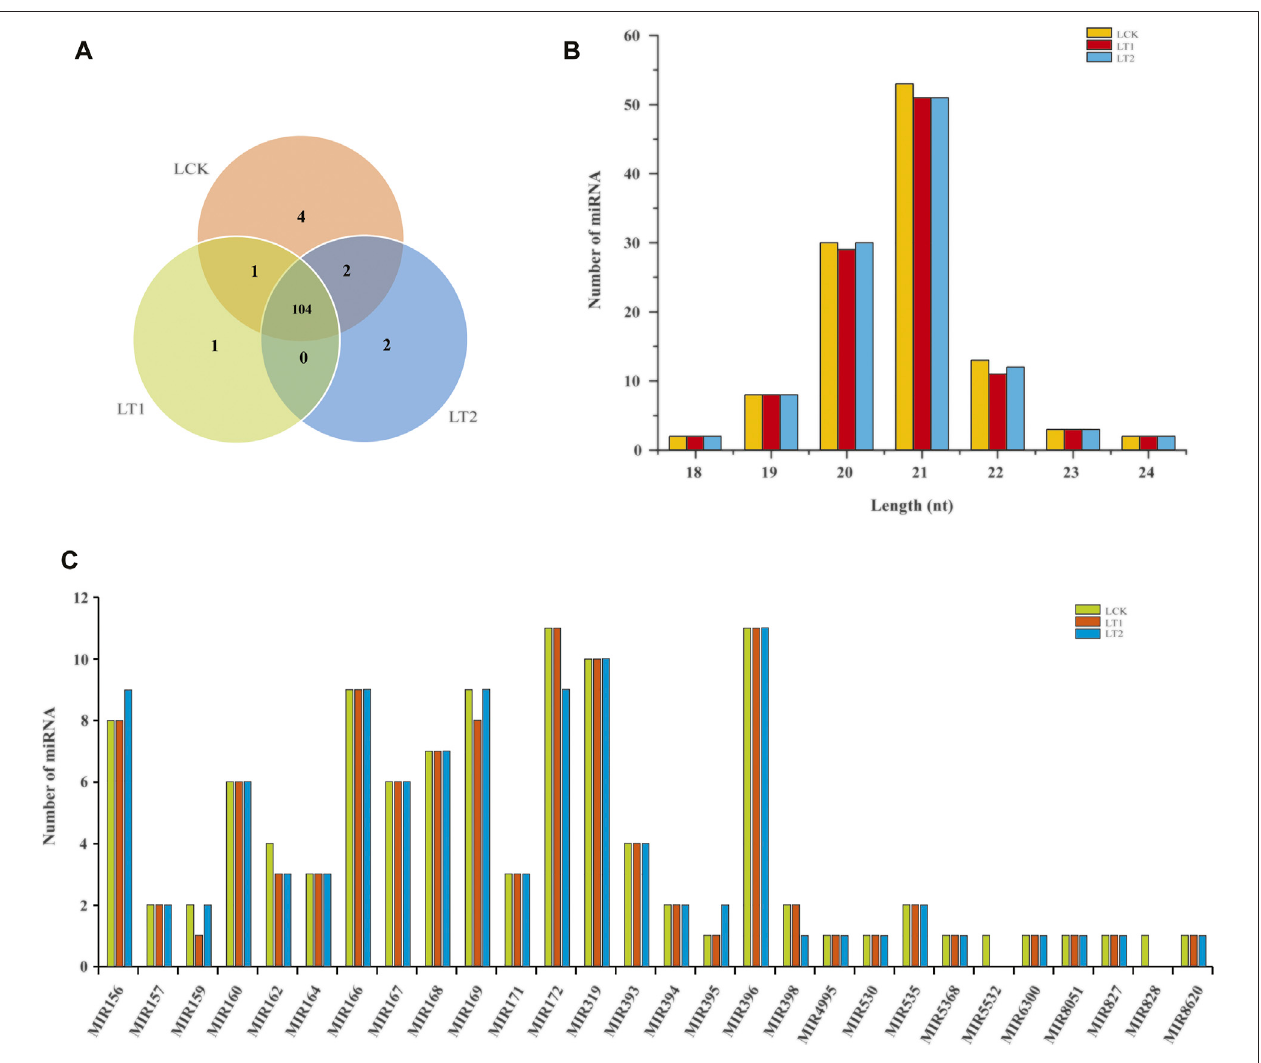
FIGURE2| SummaryofknownmiRNAs identi fi edfrom S.apetala . (A) Distribution ofknownmiRNAs insamplestreatedwithsaltfor0 days(LCK), 1 day(LT1)and 28 days (LT2). (B) Size distribution of known miRNAs in LCK, LT1 and LT2 libraries. (C) Distribution of known miRNA family size in S. apetala .